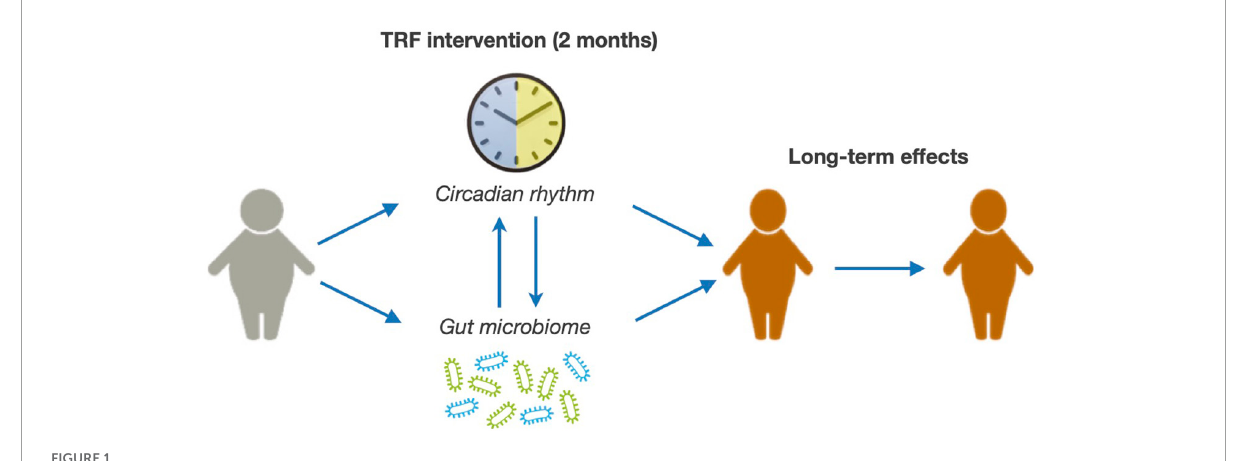
FIGURE1 Summary of the study